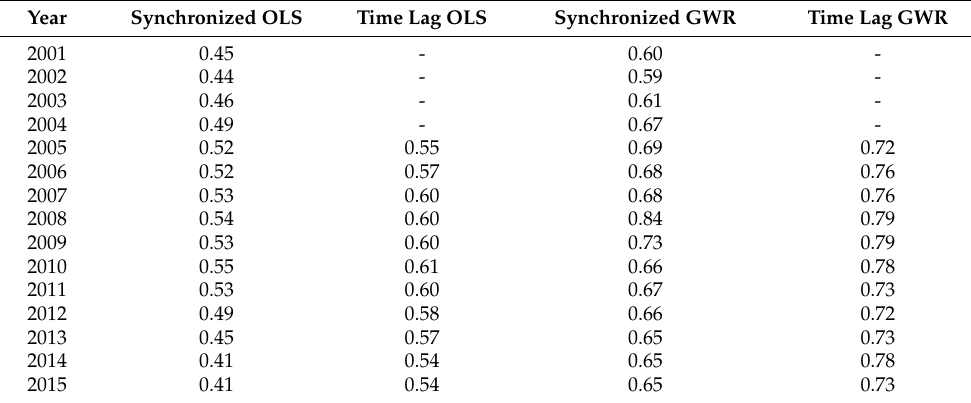
Table 7. Adjusted R 2 of 10-year interval change in population and land